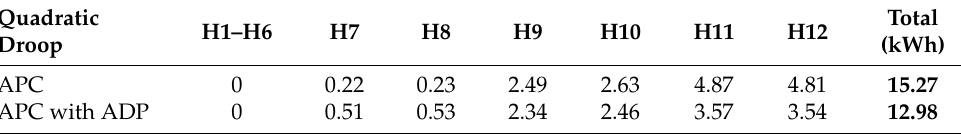
Table 3. Energy curtailed (kWh) for twelve houses with Quadratic droop.